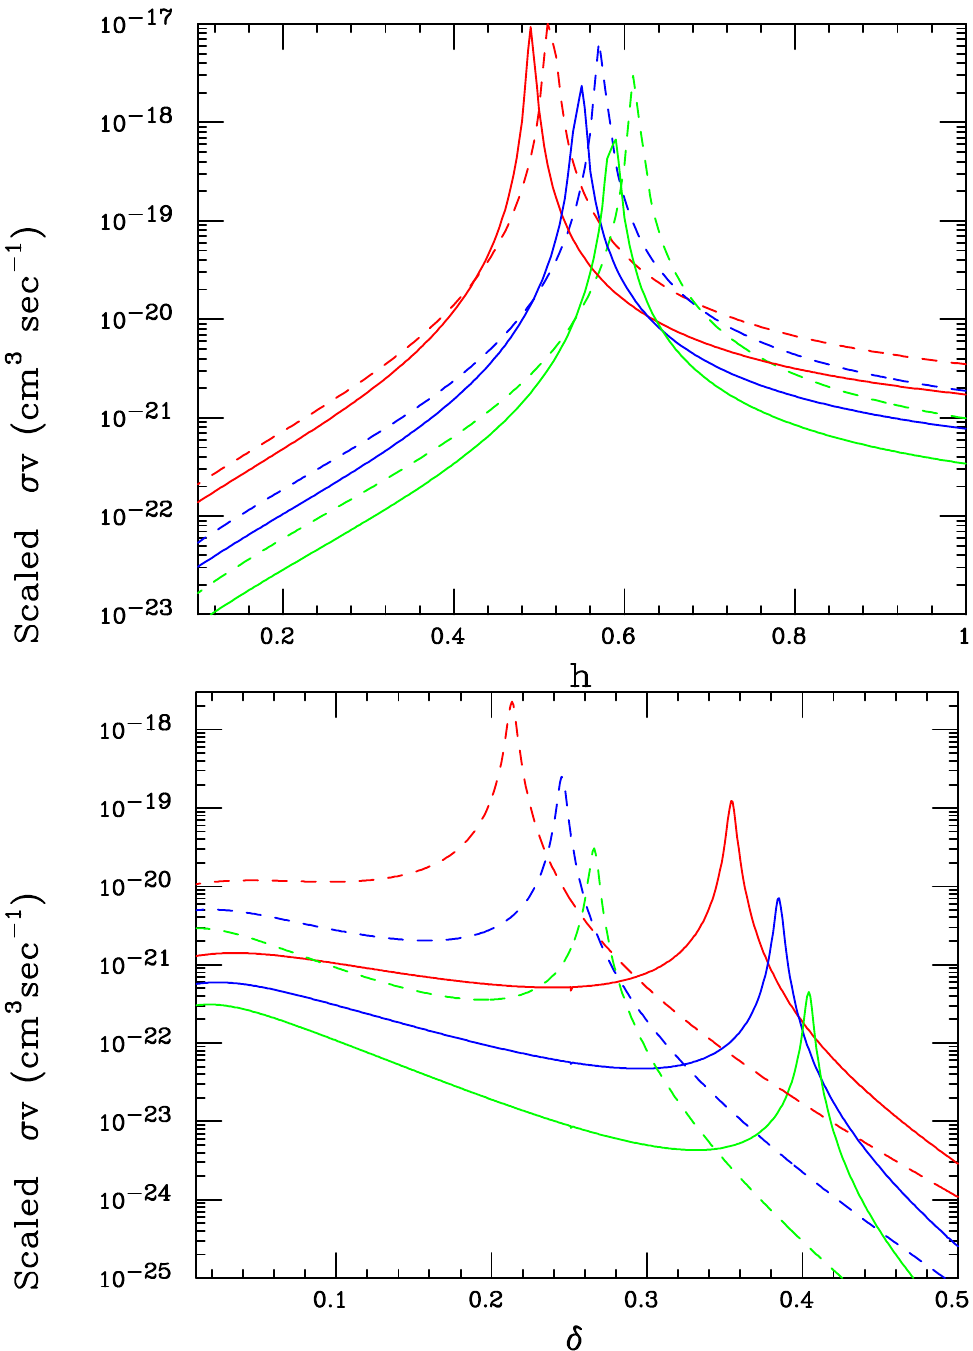
Figure 12 . Scaled annihilation cross sections for BM1(solid) and BM2(dashed) for x F =20(red), 25(blue) and 30(green) as functions of h (top) or (cid:14) (bottom) with all other BM parameters held (cid:12)xed. To get the true cross section, these results need to be rescaled by a factor of ( g D (cid:15) 1 =m DM (GeV)) 2 .